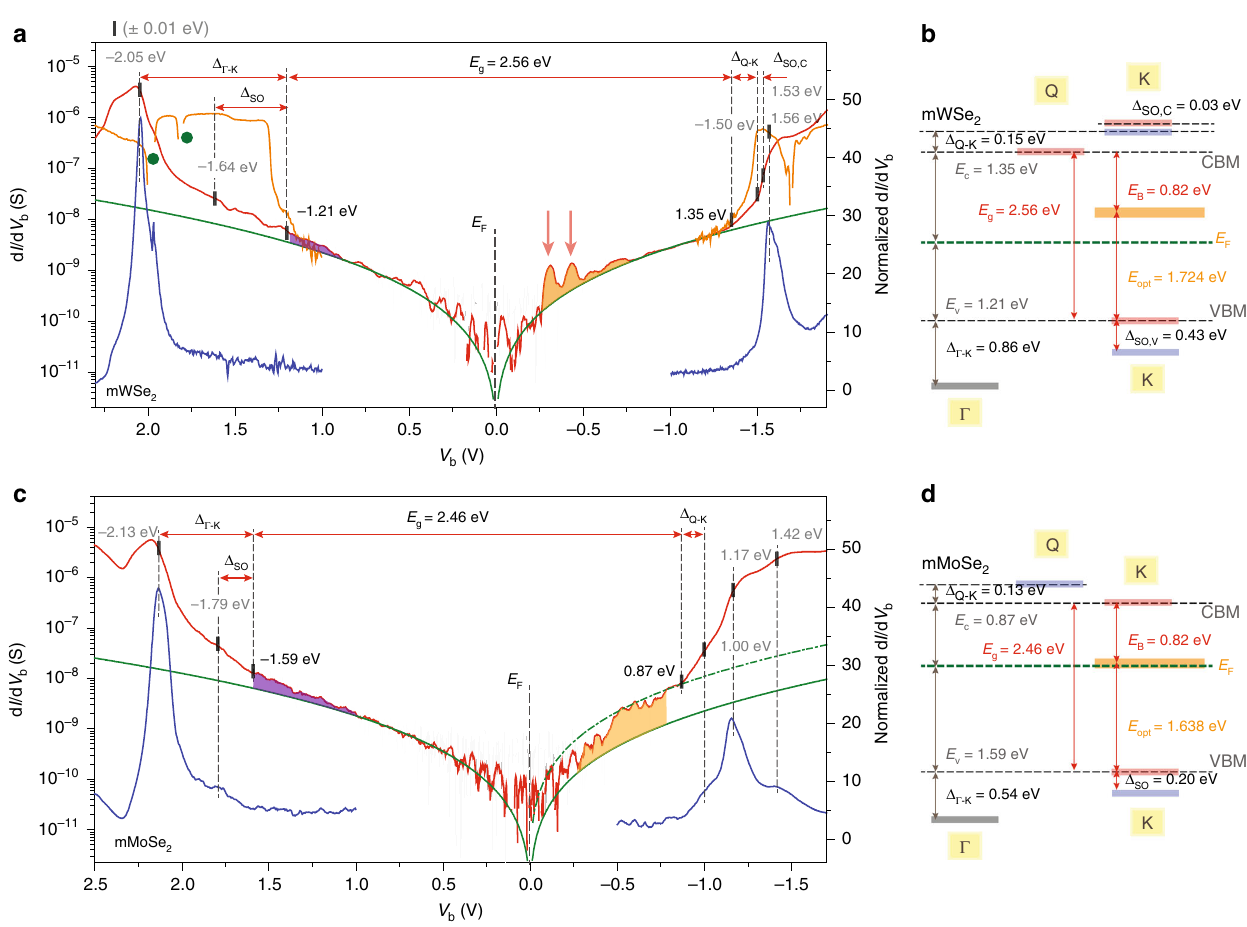
Fig. 3 Detailed electronic structure analyses from electron tunneling spectroscopy measurements of Se-based mTMDs. a , c Tunnel spectra plotted with d I /d V b in log scale from the mWSe 2 ( a ) and mMoSe 2 ( c ) planar tunnel junctions. Tunnel spectra from the crystallographically aligned device are delineated with solid orange lines, and negative d I /d V b features for resonant tunneling are marked with green circles. Solid and dotted green lines indicate the graphene baseline spectra. The areas delineated with purple and orange, respectively, represent the a 1 and e defect states from selenium-atom vacancies. b , d Summarized energy-level assignments for the mWSe 2 ( b ) and mMoSe 2 ( d ) fi lms. Uncertainty for each energy-level assignment is less than ±0.01